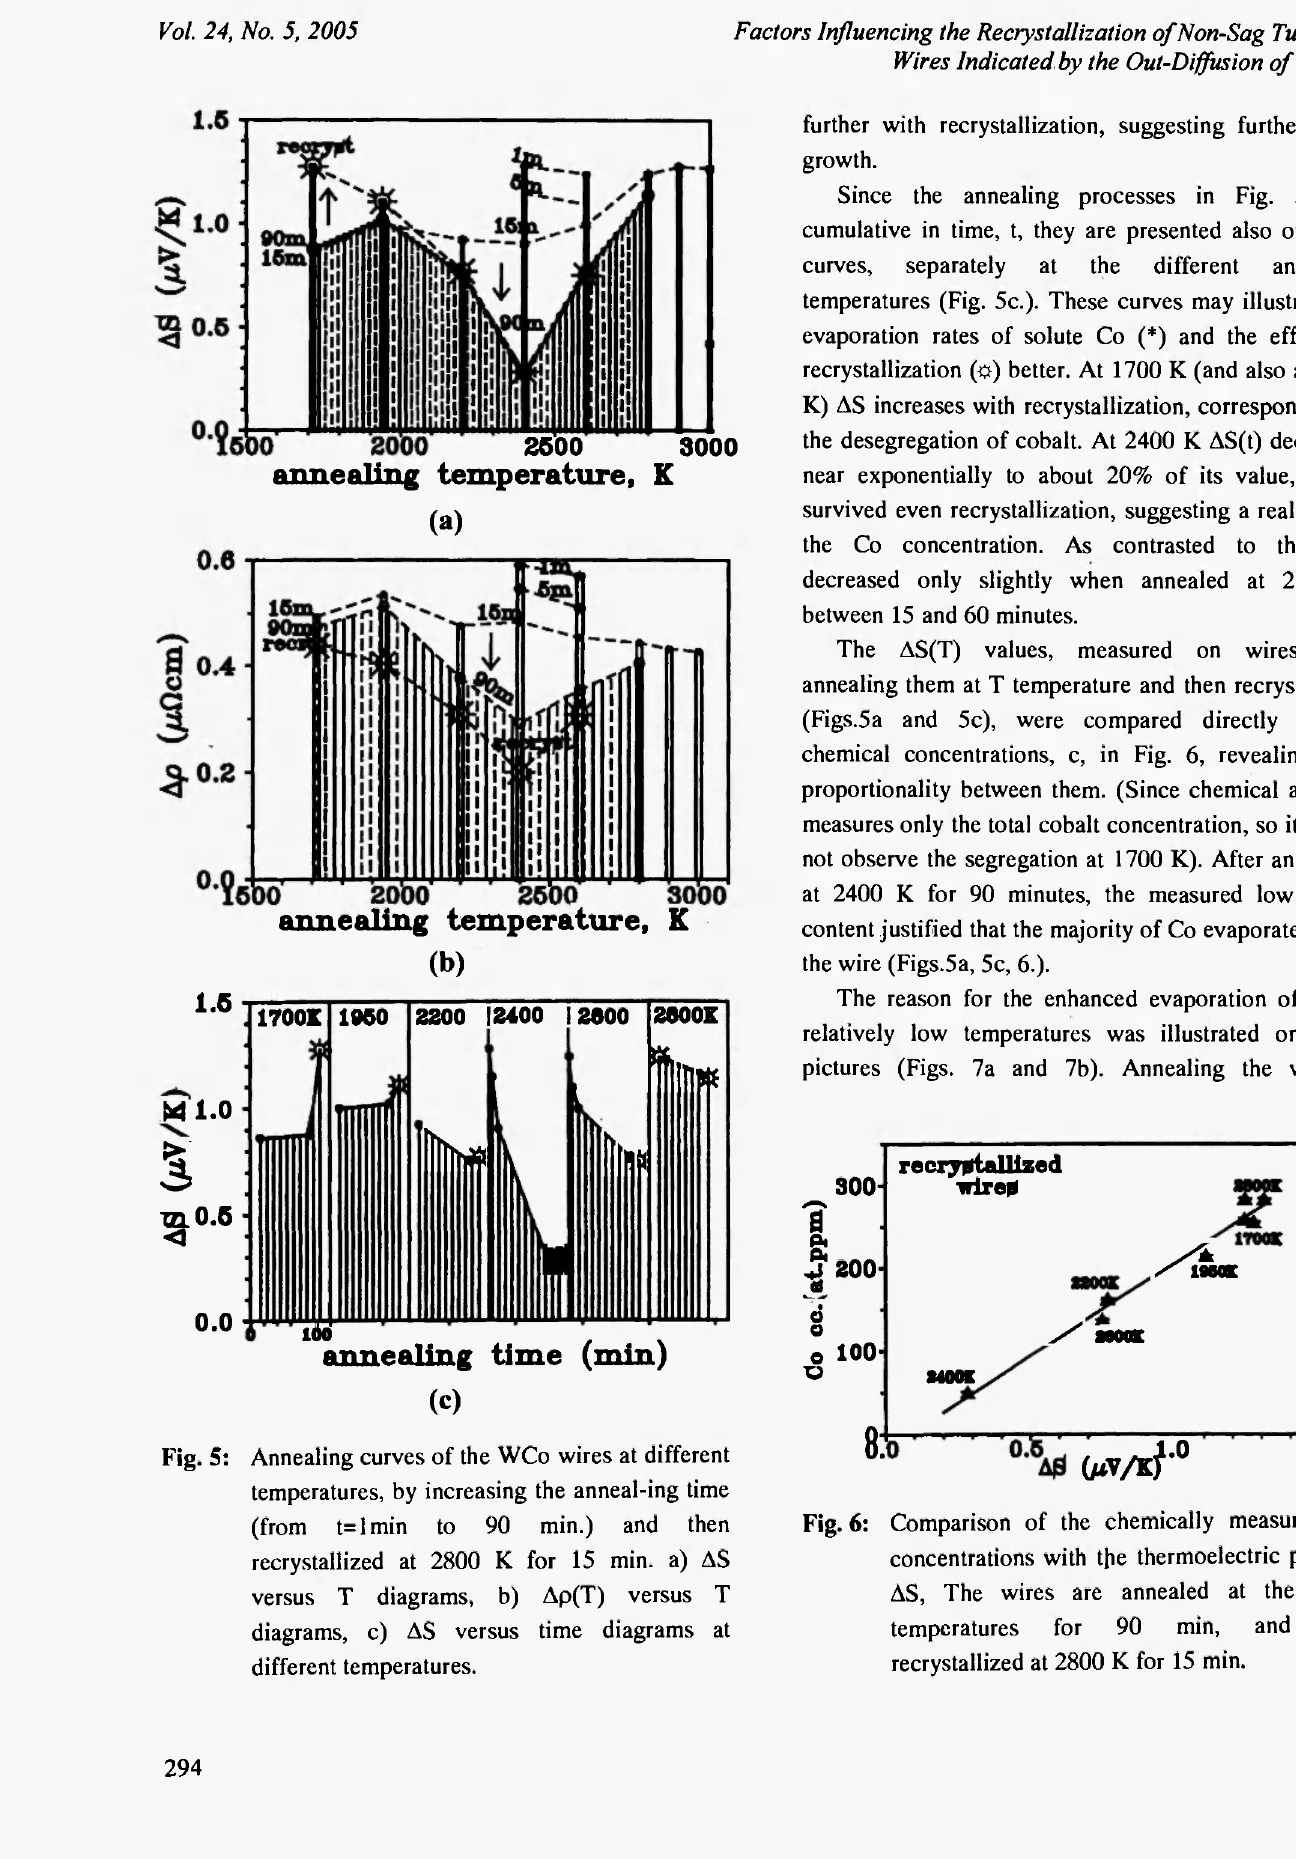
Fig. 6: Comparison of the chemically measured Co concentrations with tjie thermoelectric powers, AS, The wires are annealed at the given temperatures for 90 min, and then recrystallized at 2800 Κ for 15